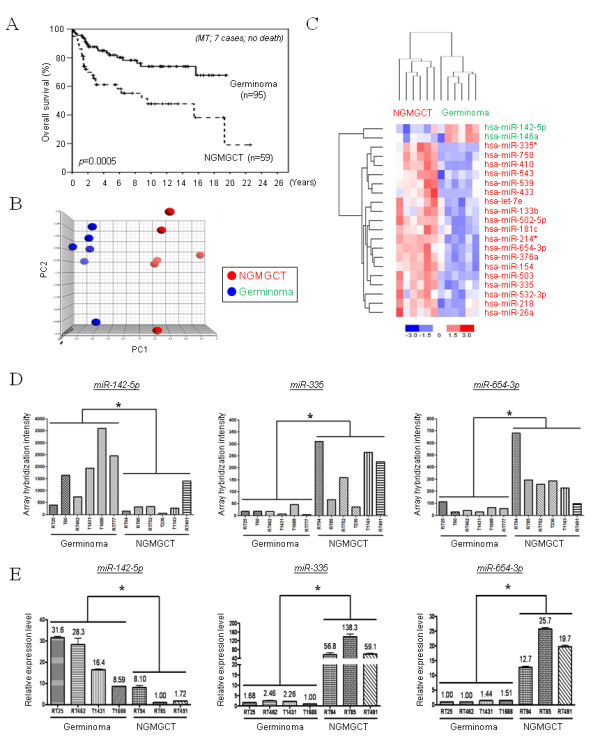
MiRNome analysis of childhood CNS GCTs. (A) Overall survival rates of GCTs of different histological subtypes. In total, 161 patients were followed up for up to 20 years. These were then subjected to Kaplan-Meier survival analysis. Numbers in parentheses are case numbers of each tumor subtype. Vertical lines indicate the censored survival observations. (B) Principal component analysis (PCA) using the filtered miRNAs (p < 0.05 and fold change ≧2). Each spot represents a single array. (C) A heat map shows the miRNAs enriched in the different prognostic groups. MiRNAs in red showed increased expression, while those in blue showed decreased. (D-E) Validation of miRNA array results by real-time PCR. The mean expression levels of the target miRNAs are compared to that of the U6 small nuclear RNA control. Results are expressed as the mean ± standard deviation (SD) (E). The miRNAs' array hybridization signals are also shown (D).